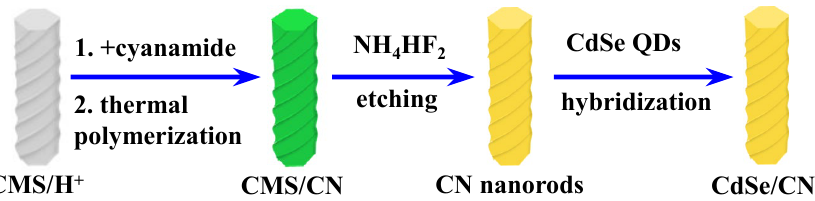
Figure 1. Schematic illustration of the synthetic process of CdSe/CN hybrids.